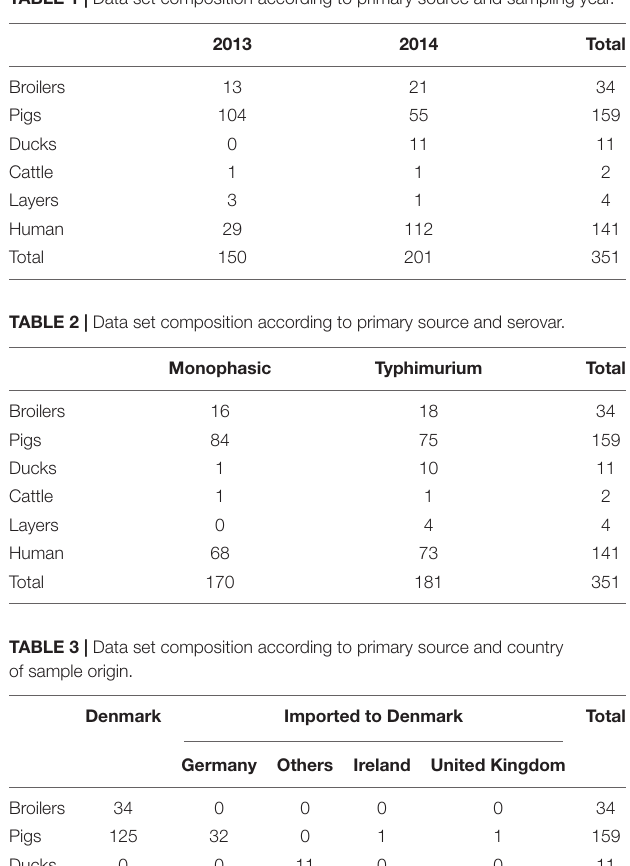
TABLE 1 | Data set composition according to primary source and sampling year.